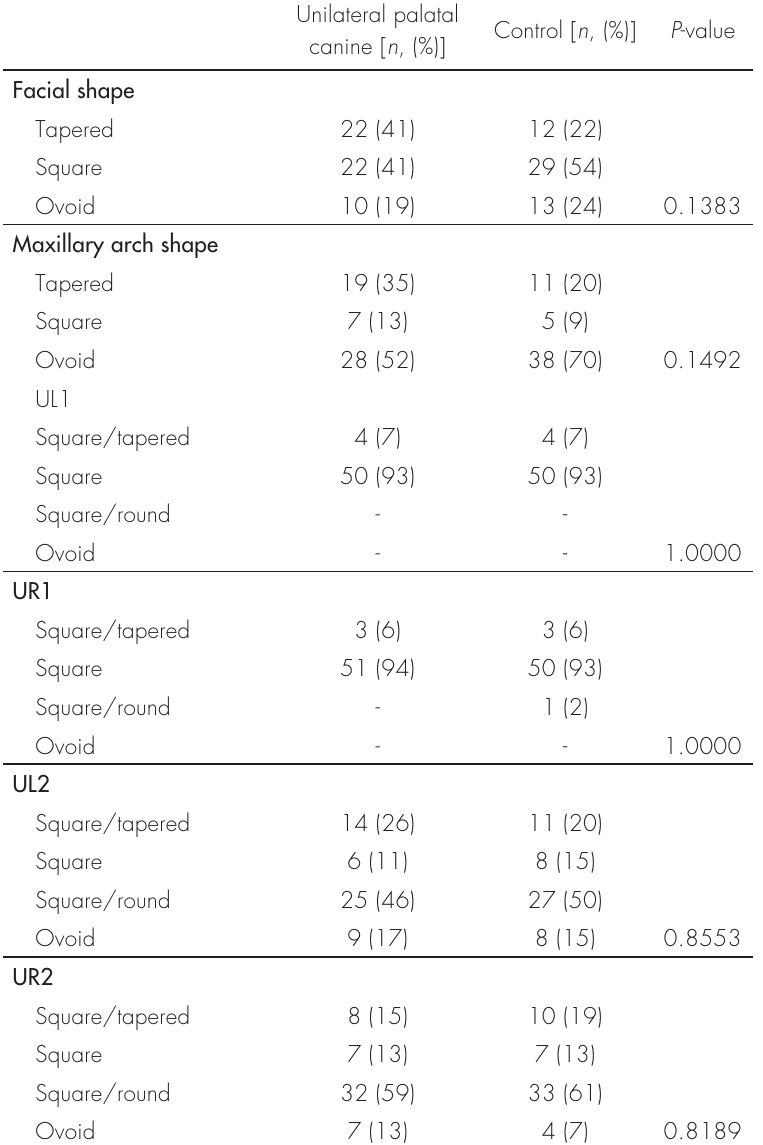
Table VI. Prevalence of facial soft-tissue, maxillary arch and incisor